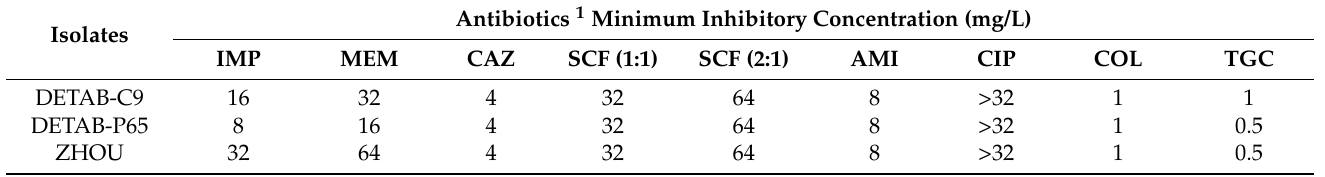
Table 1. Minimum inhibitory concentrations of antibiotics used in this